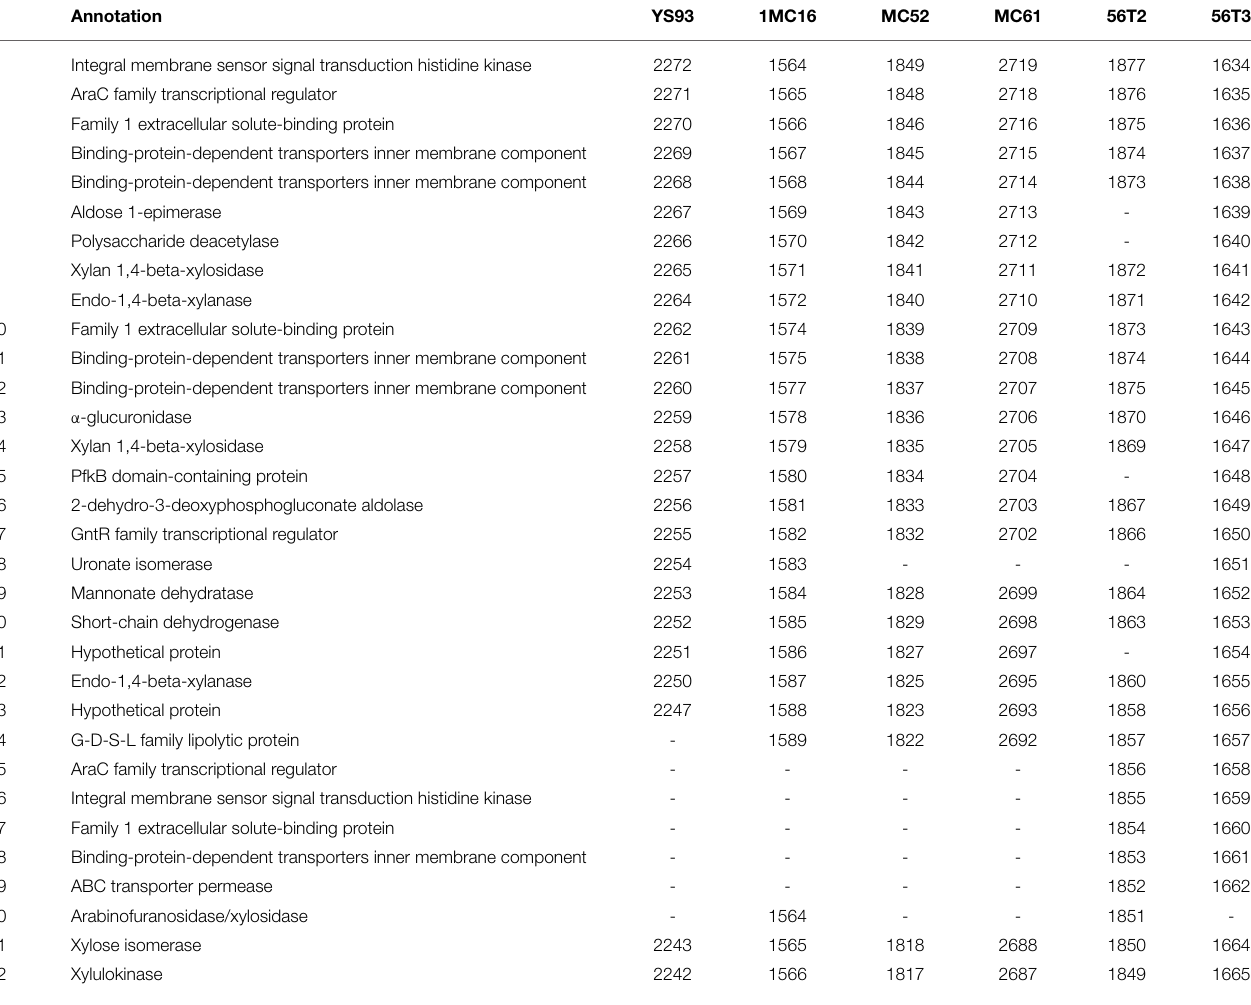
TABLE 8 | Xylose and xylan metabolic